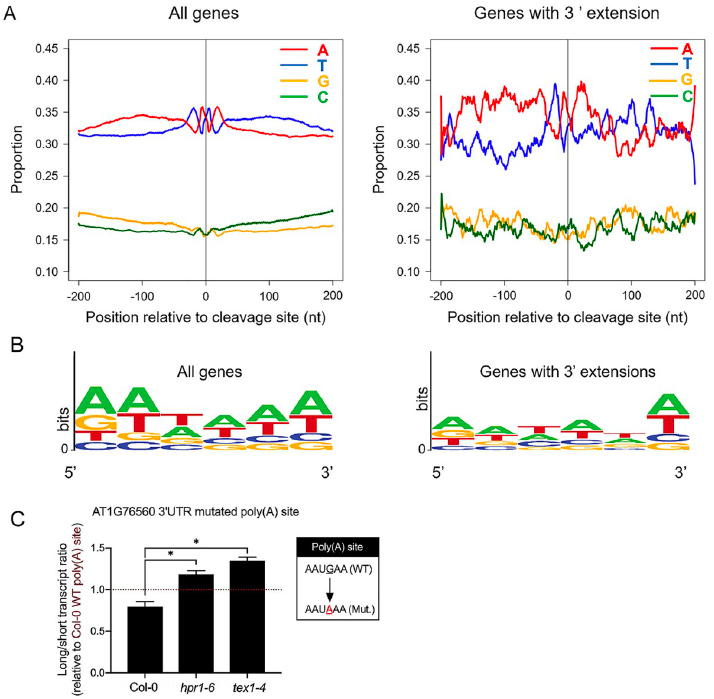
Fig 7. Nucleotide composition near the 3’ cleavage site of mRNAs. (A) Proportion of bases in a 200 nucleotide region 5’ and 3’ of the transcripts termination sites for all genes (left) or genes showing 3’UTR extensions in the hpr1-6 and tex1-4 mutant background (right). (B) Graphical representation of base enrichments found at the near upstream element sequence of all genes (left) and genes with 3’UTR extensions in the hpr1-6 and tex1-4 mutant background (right). Chi square test pvalue = 0.22 (C) Transient expression of Luciferase gene fused after the stop codon to the 3’end of the gene AT1G76560 in which the wild-type polyadenylation site AAUGAA was mutated to AAUAAA. The construct was expressed in Arabidopsis mesophyll protoplasts obtained from Col-0, hpr1-6 and tex1-4 . The bar chart shows the ratios of long-to-short transcripts in the various genotypes and values are expressed relative to the wild-type construct in Col-0. Data are means of four samples with each sample being an independent transfection of protoplasts. Error bars represent standard deviation. Asterisks denote statistical significance (P < 0.05) from the Col-0 control according to Student’s t